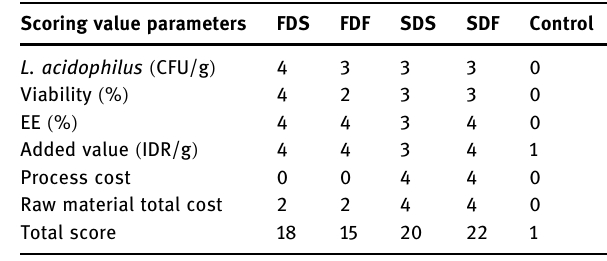
Product or hydrated L. acidophilus ( g )